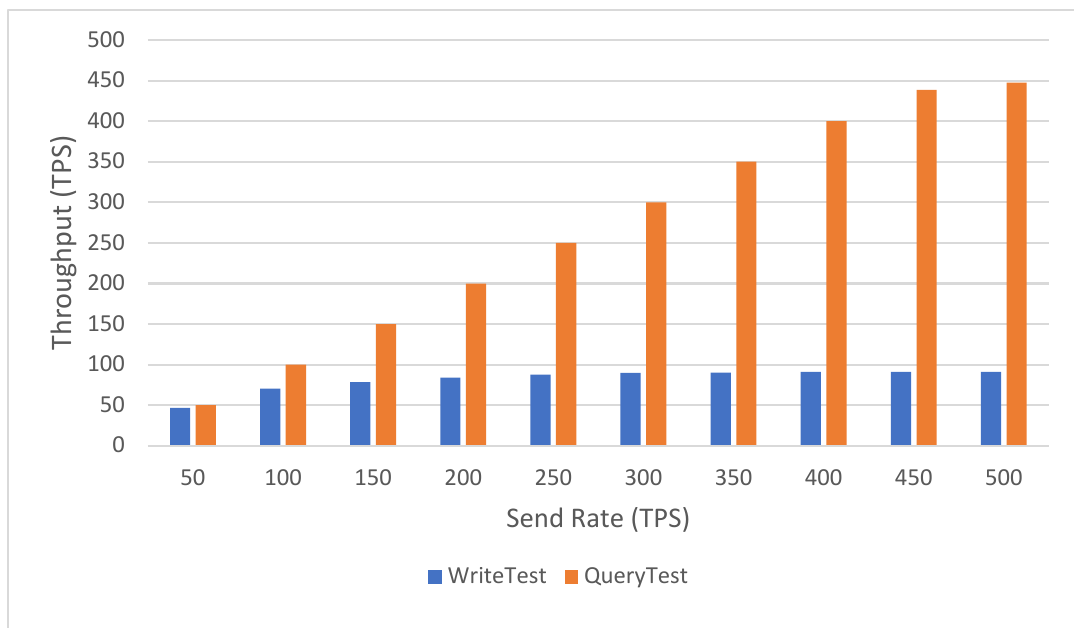
Figure 11. Throughput of the system at various send rates.